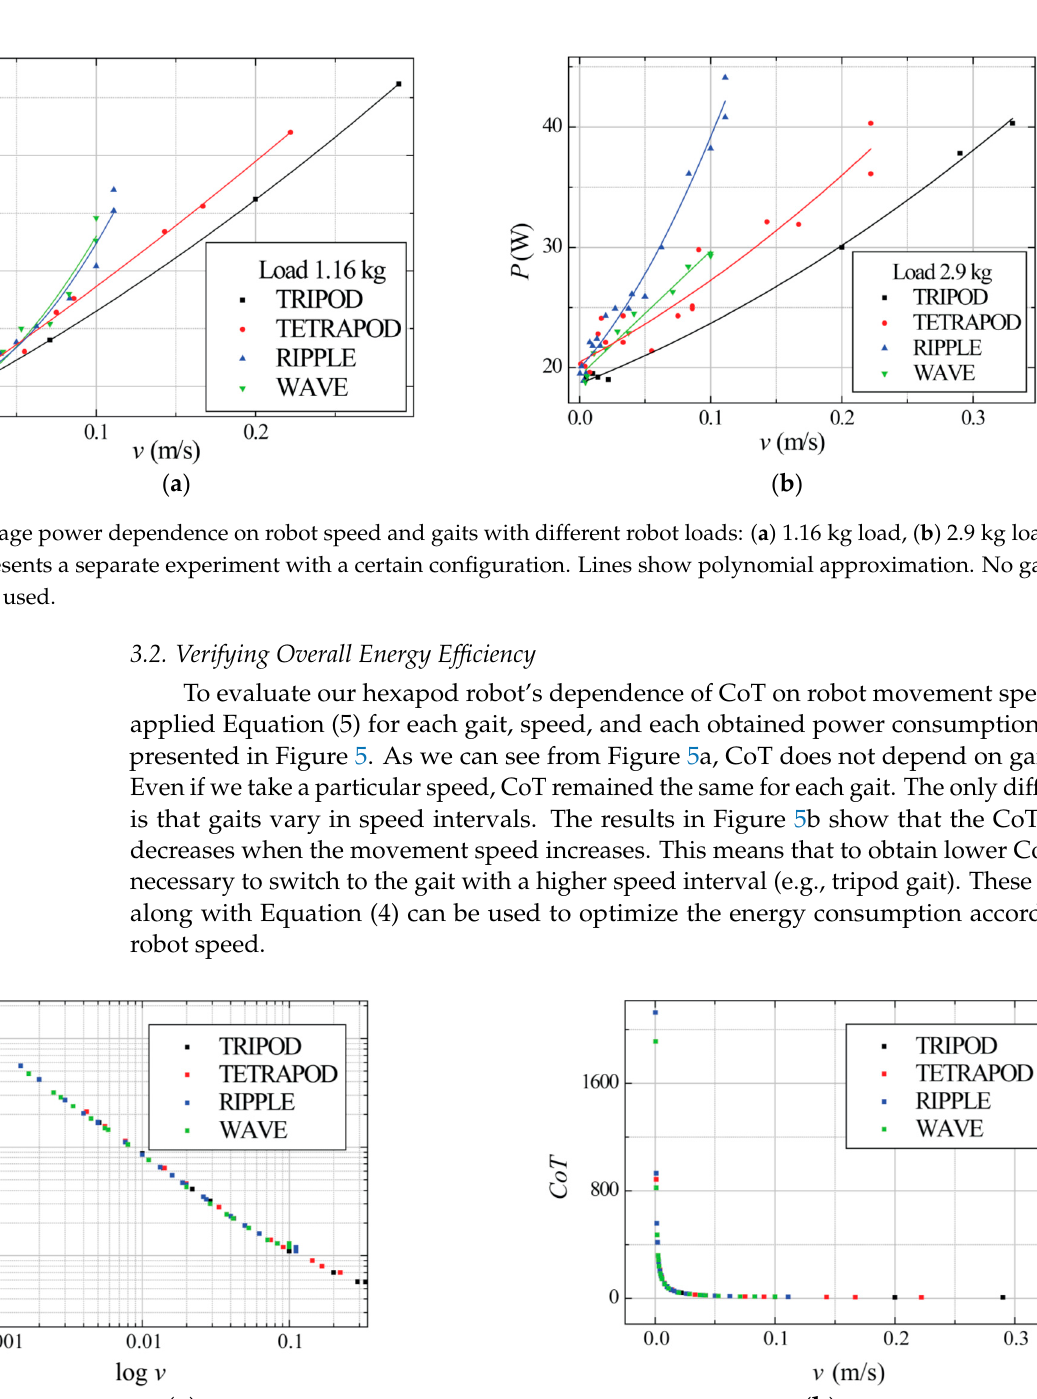
Figure 5. Cost of transport dependence on robot speed: ( a ) logarithmic scale, ( b ) linear scale.